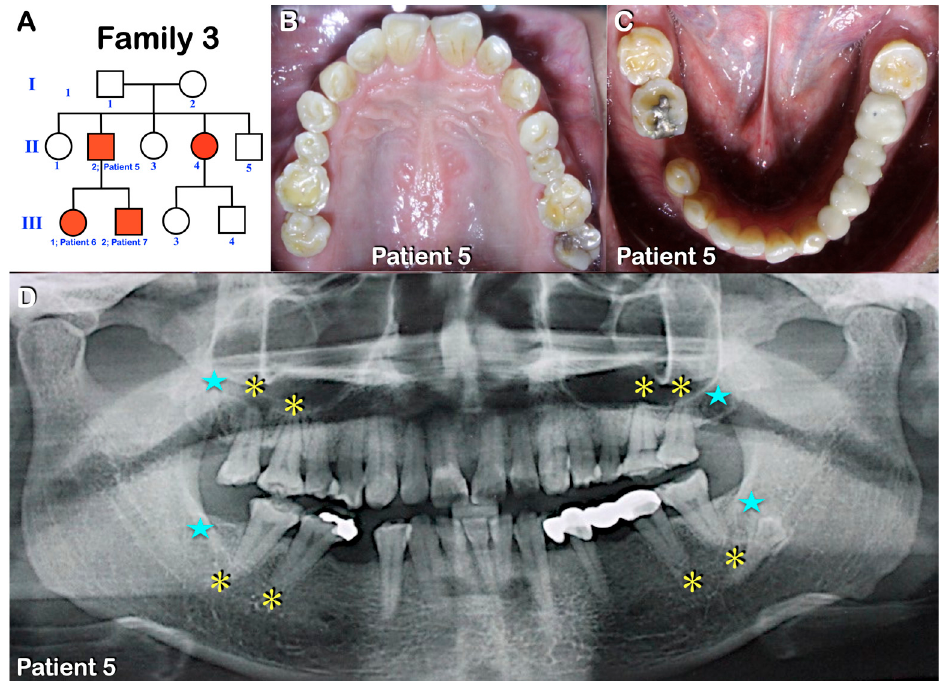
Figure 4. Family 3. ( A ) Pedigree of family 3. Patients 5–7. ( B , C ) Patient 5. Permanent dentition. Round-shaped permanent molars, molars with multiple supernumerary cusps, and premolars with single prominent cusps. ( D ) Patient 5. Panoramic radiograph showing agenesis of all third permanent molars (blue stars), single-rooted permanent molars, and taurodontism (yellow asterisks).